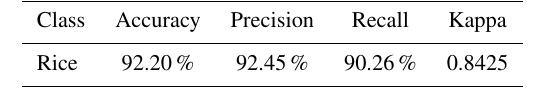
Table 4. Accuracy of the rice area map based on the validation set.